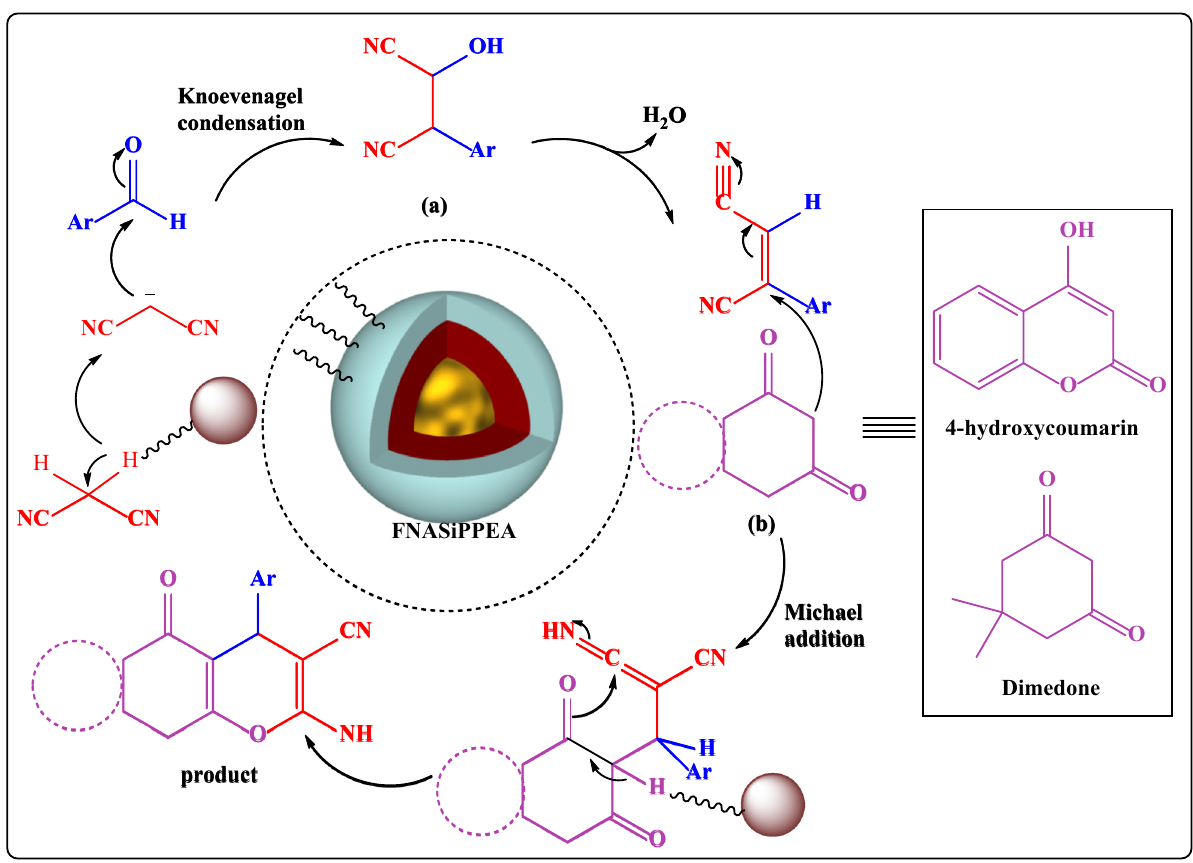
Figure 13. Proposed mechanism for synthesis of DHPC and